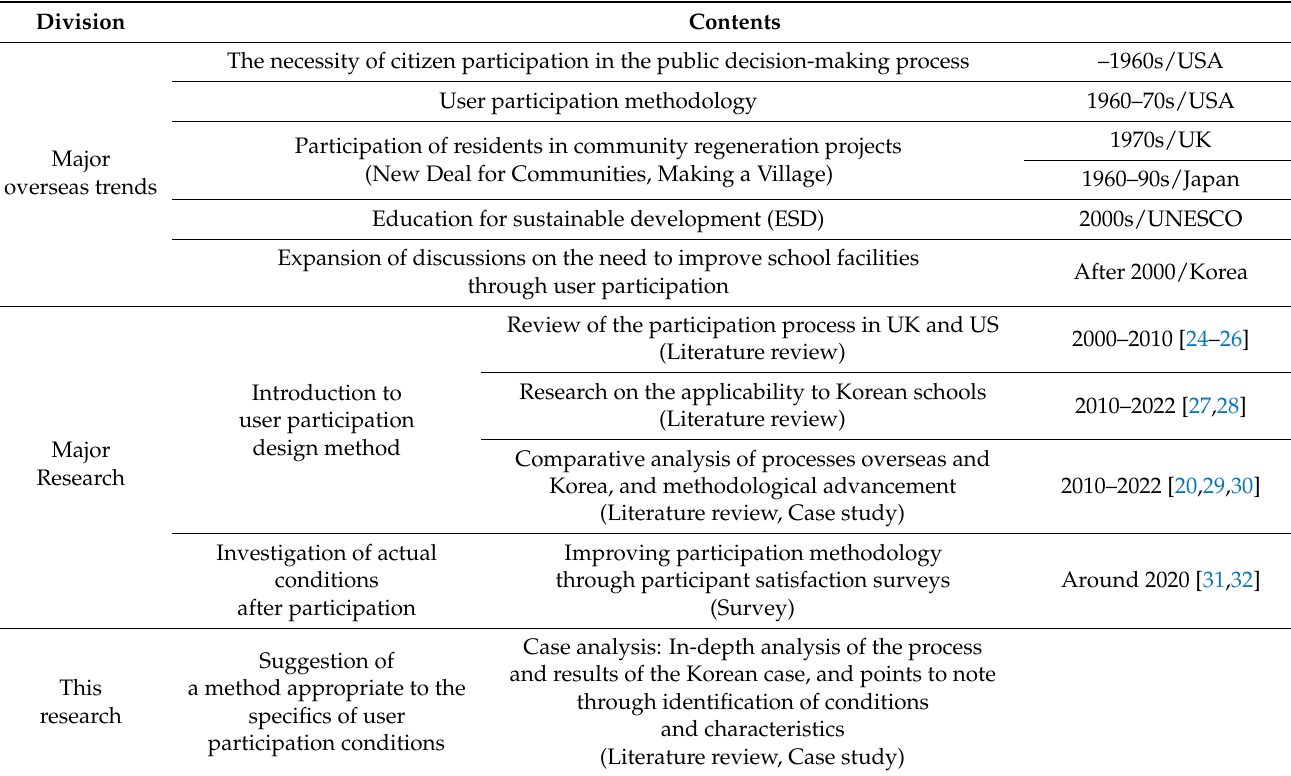
Table 1. Major trends and